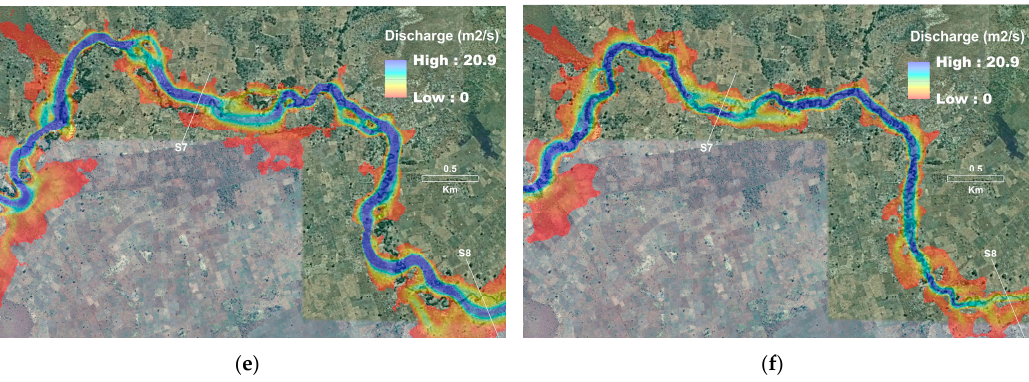
Figure 7. Predicted water depth, velocity and specific discharge maps in the reach between S6 and S8 with the original DEM at t = 56,000 s (left) and with the conditioned DEM at t = 18,000 s (right). Manning’s value of n = 0.03 m − 1/3 ·s: ( a ) Depth, DEM SRTM; ( b ) Depth, DEM SRTM TR ; ( c ) Velocity, DEM SRTM; ( d ) Velocity, DEM SRTM TR ; ( e ) Specific discharge, DEM SRTM; and ( f ) Specific discharge, DEM SRTM TR .